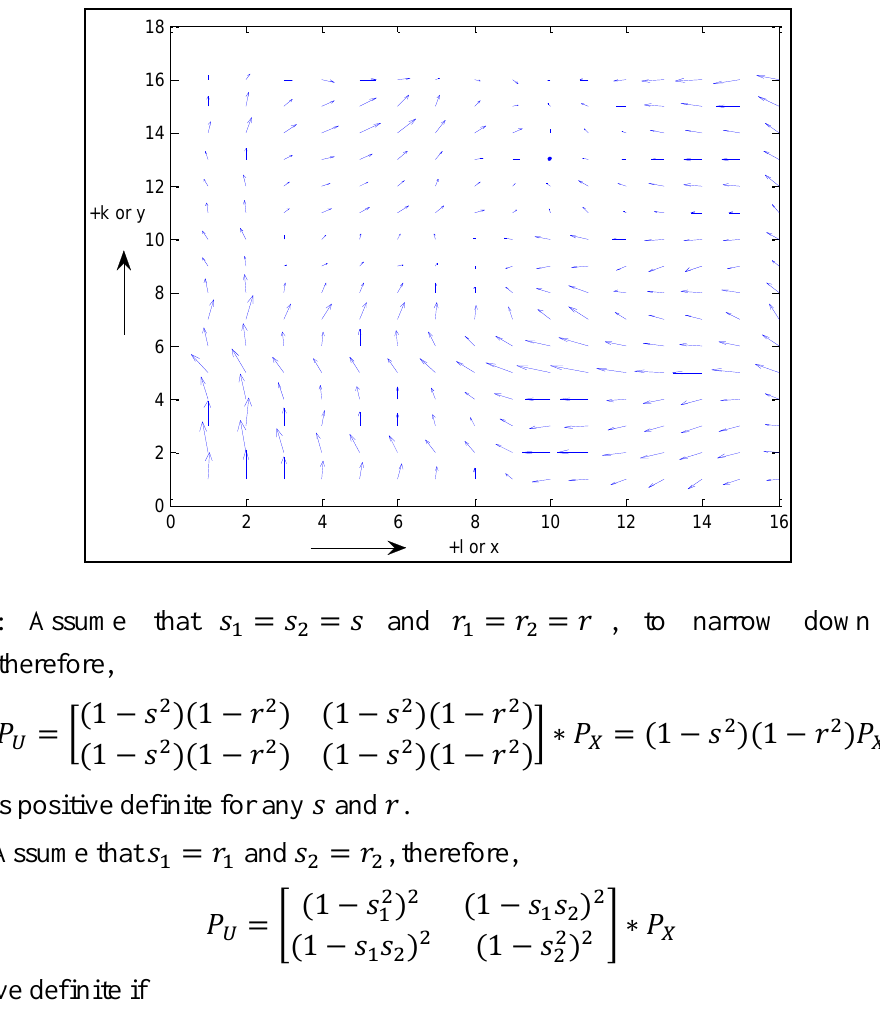
Figure 13. Realization of two-dimensional multivariate errors over a 2D grid: high spatial correlation in the grid’s or y-direction and high spatial correlation in the grid’s or